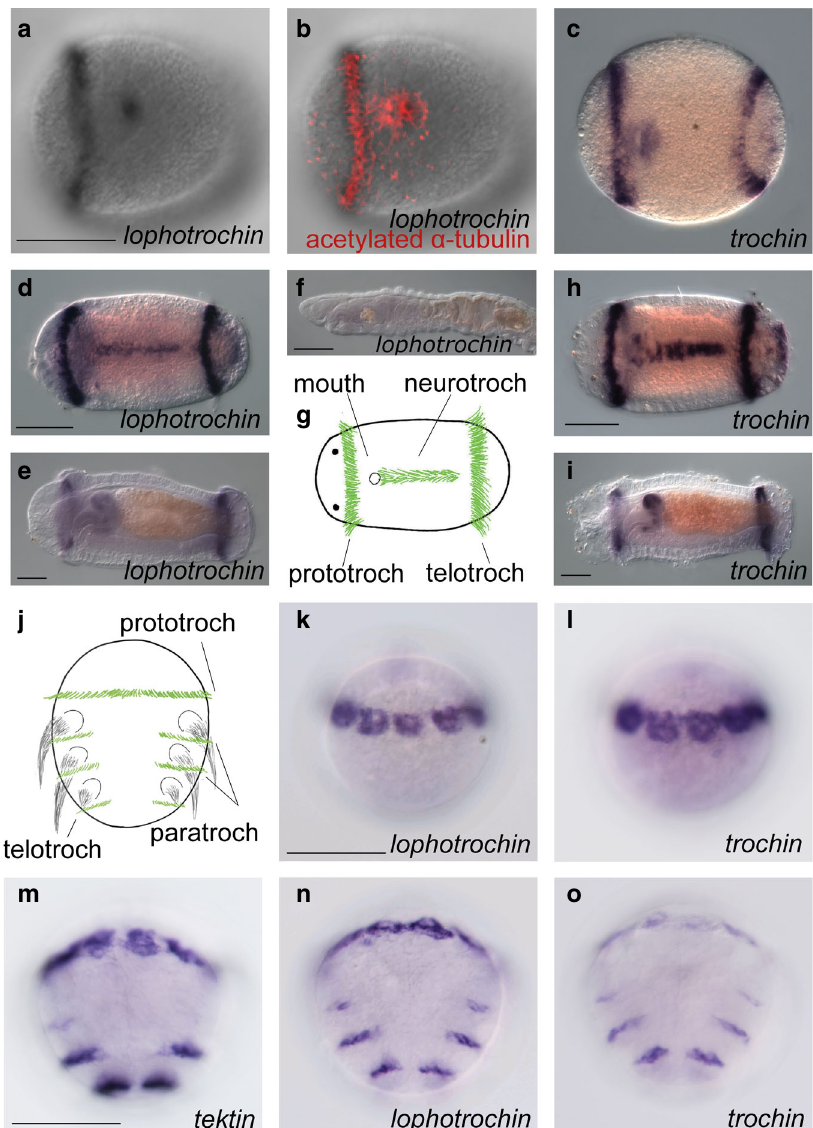
Fig. 3 Lophotrochin and trochin expression in annelids. a – i Capitella teleta : lophotrochin and trochin show a similar expression pattern throughout development and expression of both genes is restricted to a subset of ciliated structures. a In early stage 4 larvae, lophotrochin (black) is expressed in the prototroch and the ciliated area around the mouth. Ventral view, bright fi eld. b Labeling of cilia in the same larva with acetylated α -tubulin antibody (red) merged with ( a ). c In late stage 4, trochin (purple) is expressed in the prototroch, the area around the mouth, and in the telotroch, ventral view. d Lophotrochin (purple) expression is seen in prototroch, telotroch and neurotroch, in stage 6, ventral view. e In stage 8, lophotrochin is expressed in the anterior esophagus and pharynx. Expression in the prototroch and telotroch is reduced compared with that in stage 6. Lateral view. f Lophotrochin expression is undetectable after metamorphosis, juvenile, lateral view. g Diagram of a mid-stage larva, showing the prototroch (left, vertical), neurotroch (center, horizontal), and the telotroch (right vertical band). Cilia in green. h Trochin expression in stage 6 larva, ventral view. i Trochin expression of stage 8, lateral view. j – o Platynereis dumerilii : expression of lophotrochin and trochin is very similar, and is restricted to ciliary bands. j Diagram of the ciliary bands of the larva of the annelid Platynereis , cilia in green and chaetae in black. k At 24 h post fertilization (hpf), lophotrochin (purple) is expressed in the prototroch cells, ventral view. l Trochin ’ s expression pattern (purple), 24 hpf, ventral view. m In 48-hpf larva, expression of a conserved ciliary marker Tektin-3/5A (purple) is shown in the prototroch (now a thinner ring of cells), the ciliated apical organ (out of plane in this image), a larger telotroch, and in two pairs of rows (paratroch 1, weakly, and paratroch 2) between the fi rst three pairs of trunk segments/parapodia, ventral view. Expression of ( n ) Lophotrochin and ( o ) trochin in the same stage (48 hpf) larva show almost identical pattern to the Tektin-3/5A ( m ). Scale bars: 100 μ m. For each in situ hybridization, at least 20 animals were stained and all had the pattern ciliary band 46 ; however, it is not known if the lophophore forms directly from these band cells.